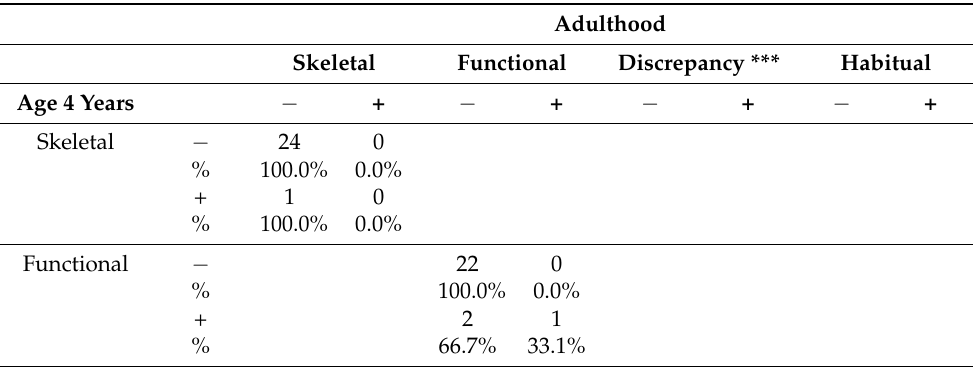
Table 7. Distribution of causative factors at 4 years of age and in adulthood (around 35